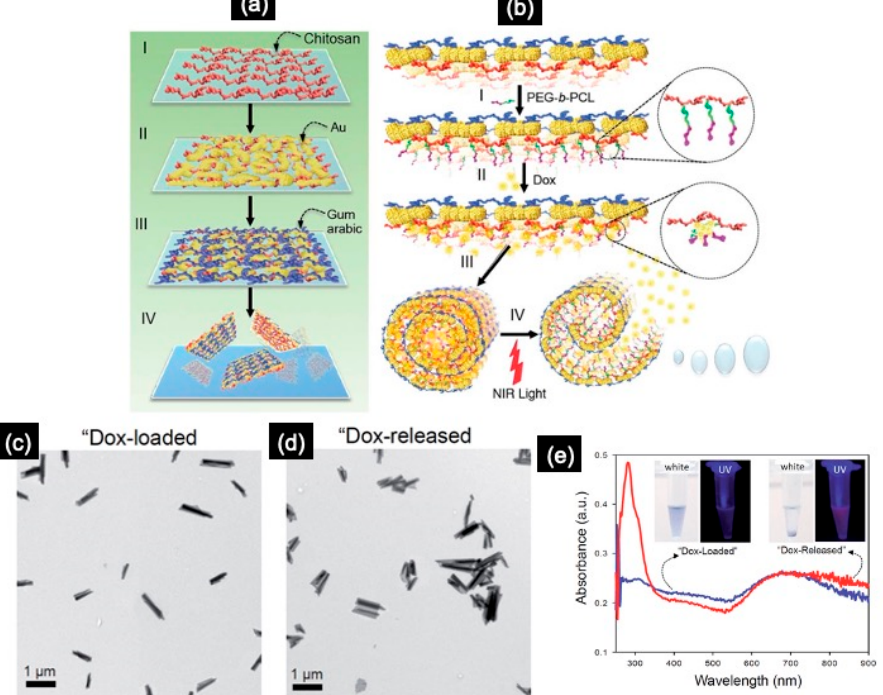
Figure 7. ( a ) Scheme illustrating the preparation of Janus composite Au-NSHs: ( I ) the chitosan matrix was spin-coated onto a glass wafer, ( II ) Au was sputtered onto the polymer-coated surface until a near-percolating Au thin film was obtained, ( III ) the Au surface was functionalized with gum arabic and ( IV ) dipped in acetate solution and exfoliated by ultrasonication, followed by purification and resuspension of the NSHs in deionized water. ( b ) The functionalization of poly( ε -caprolactone)-b-polyethylene glycol (PEG-b-PCL) block copolymers on the chitosan side of NSH ( I ), drug (Dox) loading ( II ), triggered scrolling ( III ), and NIR-induced unscrolling of a NSH resulting in drug release ( IV ) [79]. TEM images of nanoscrolls loaded with Dox before release ( c ) and after release by near-infrared (NIR) irradiation ( d ). UV/Vis absorption spectra of the corresponding Dox-loaded (blue) and released (red) nanosheet solutions ( e ). Adapted by permission from Ref. [79]. Copyright 2016, Royal Society of Chemistry.